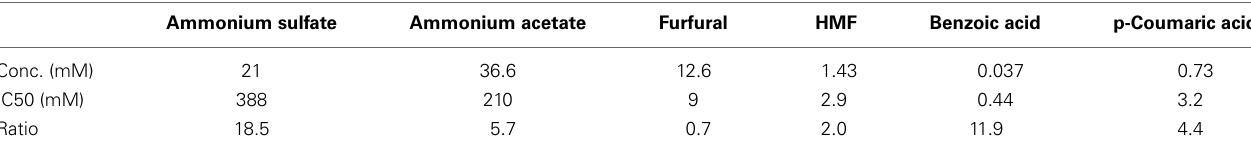
Table 5 | The IC50 values and the ratio of the IC50 value to Conc. value (the concentration of the toxic compound identified in the saccharified slurry, mM) for C. necator.